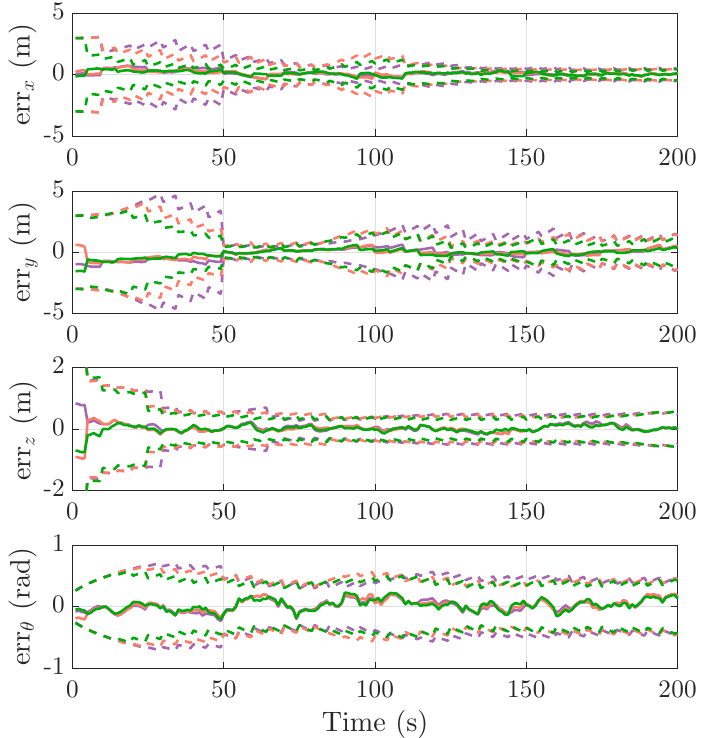
Figure 13. Object tracking errors and covariance of three